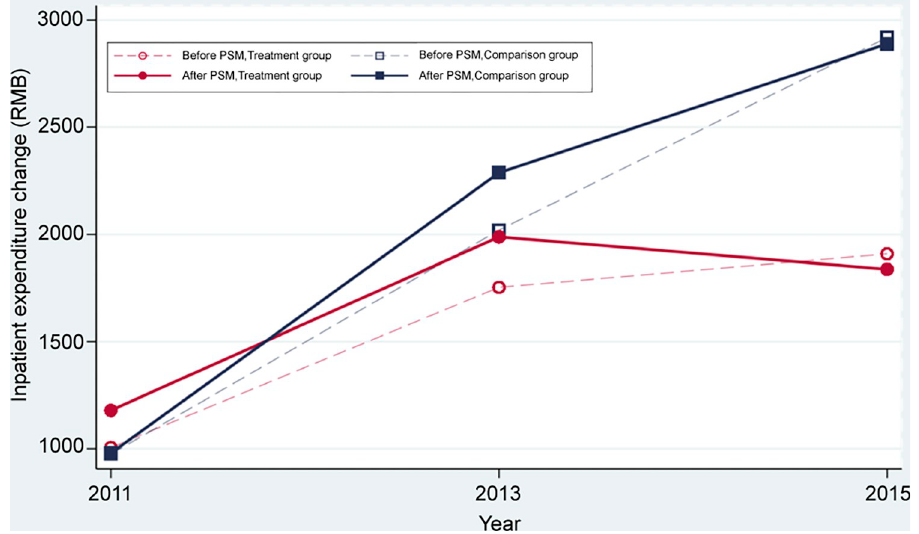
Fig 3. Comparison of inpatient expenditure of treatment and control comparison before and after PSM